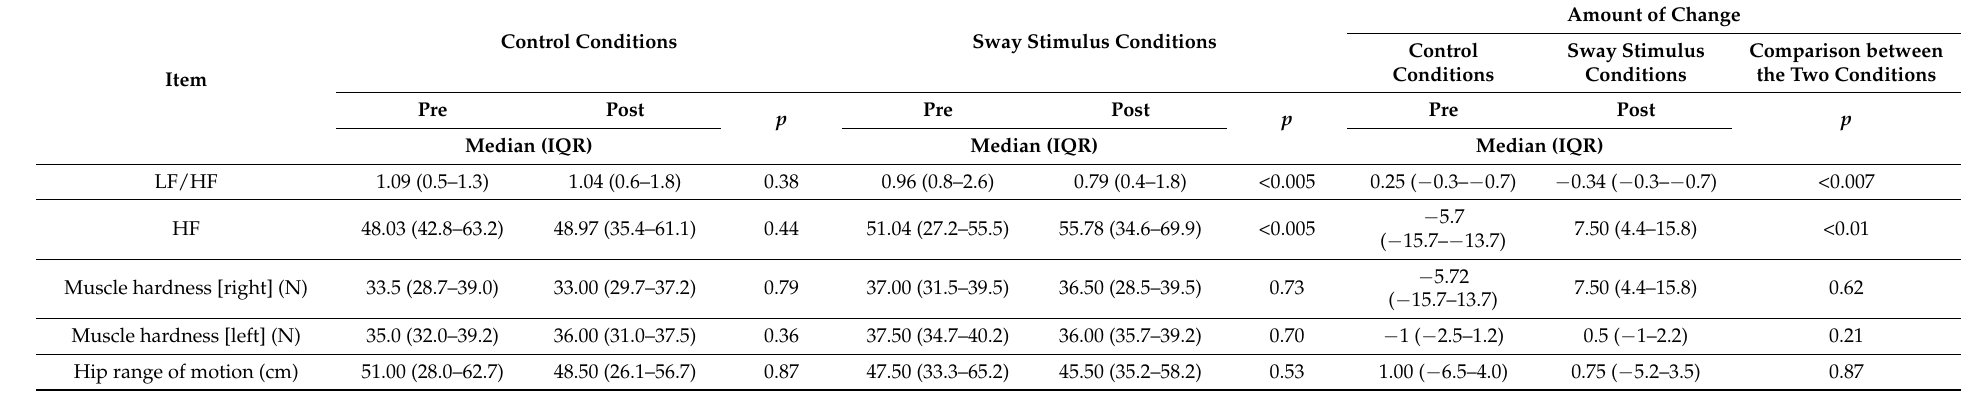
Table 2. Median (interquartile range) and the amount of change between conditions for each measured item before and after swaying under each